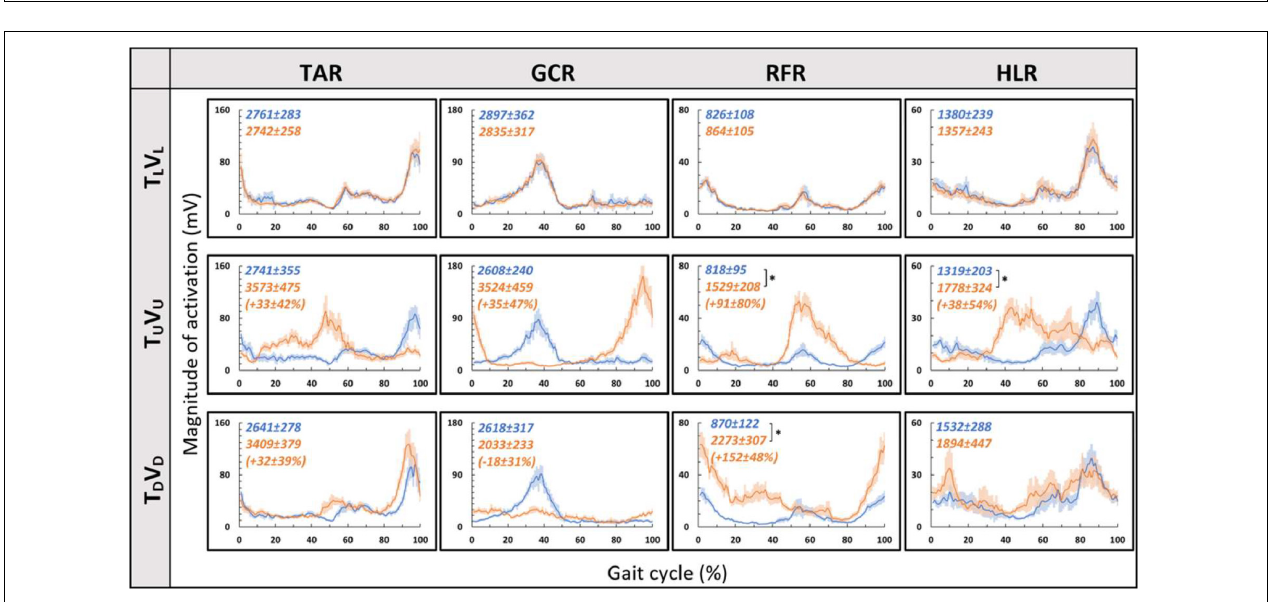
FIGURE 3 | Visual field dependence relative to misperception of visual verticality. The extent of visual field dependence during locomotion with inclined surfaces is linked to the misperception of visual verticality. The X -axis represents the misperception of the visual verticality index assessed by the psychophysical rod and frame test while seated. The Y -axis represents the individual response index to virtual inclines based on the incongruent conditions, and each circle represents a participant (see section “Materials and Methods”). A significant correlation was found between these measures [Pearson’s R = 0.76, p = 0.004, t (10) = 4.075], suggesting that they may be relying on joint mechanisms. The dotted line represents the linear regression line Y = 0.472 X + 0.1.